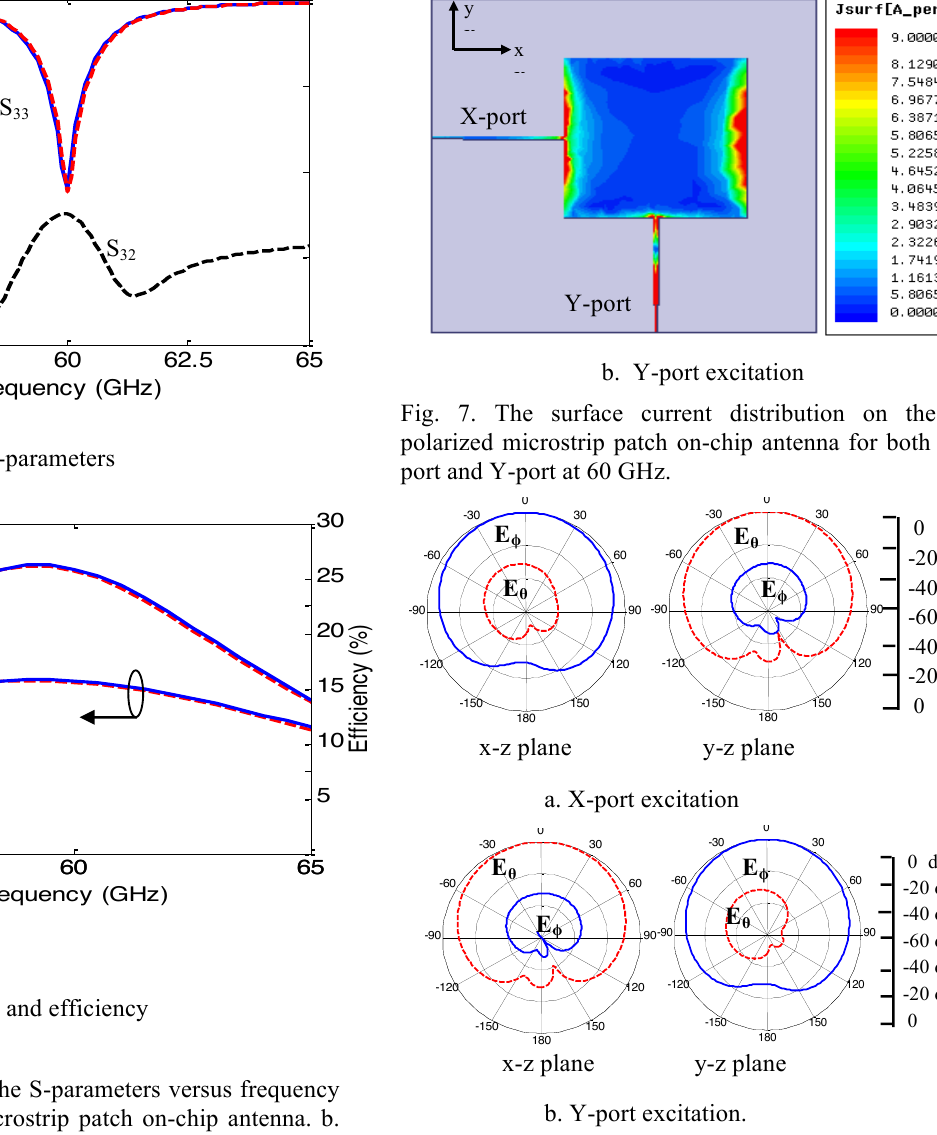
Fig. 8. The radiation patterns of the dual-polarized microstrip patch on-chip antenna for both the X-port and Y- port at 60 GHz in different